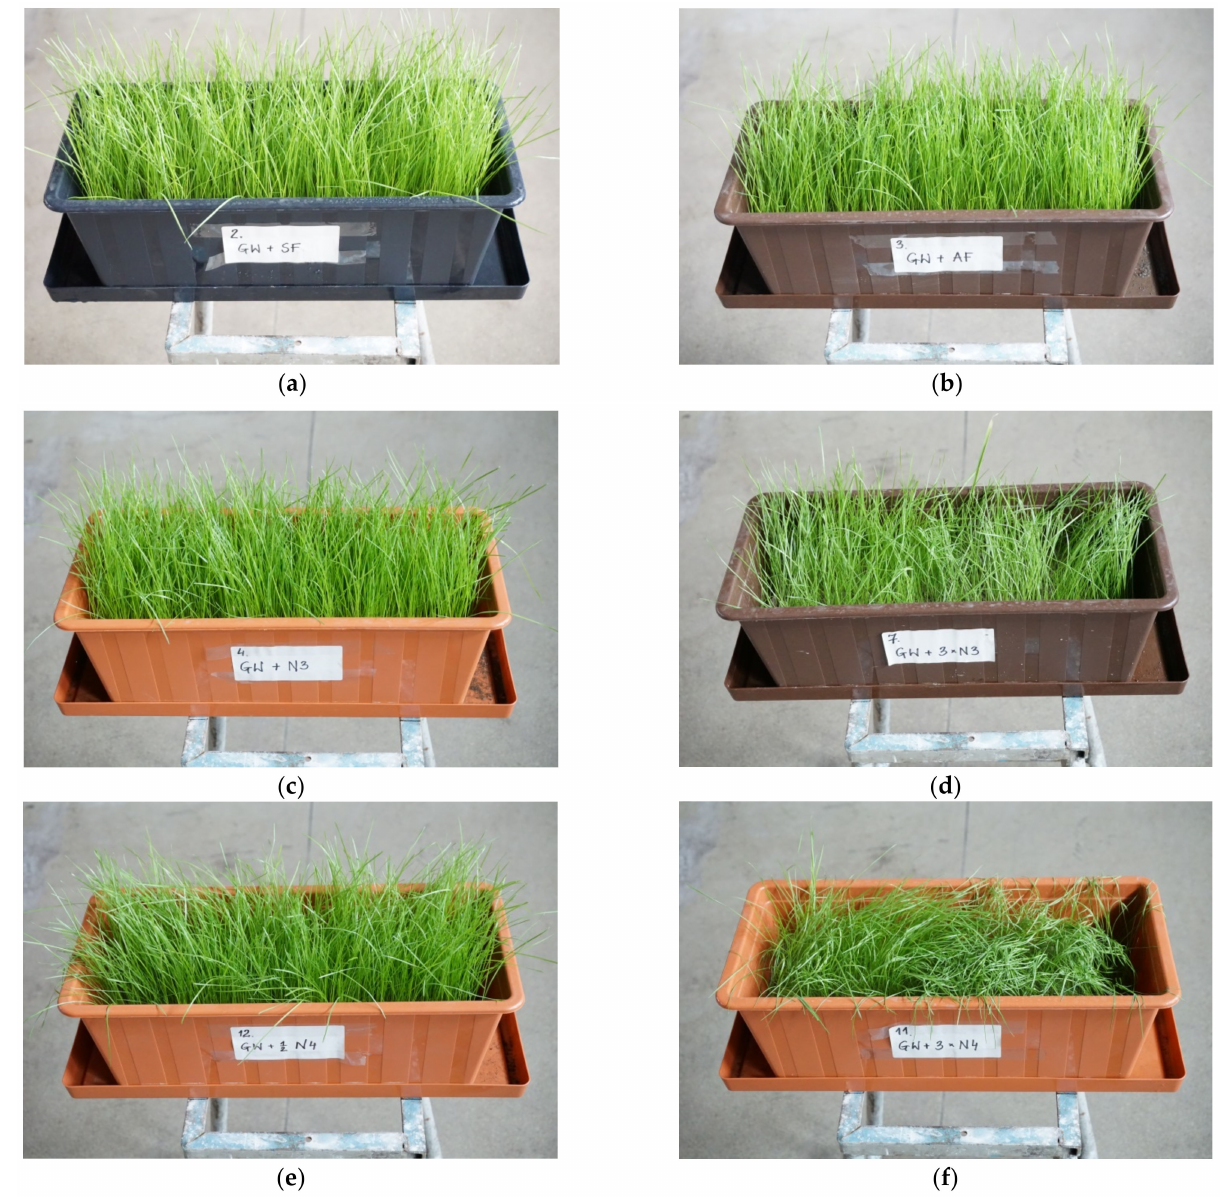
Figure 7. Pot cultivation–view on the 17th day from the start of cultivation: ( a ) biomass growth in test P2; ( b ) biomass growth in test P3; ( c ) biomass growth in test P5; ( d ) biomass growth in test P8; ( e ) biomass growth in test P9; ( f ) biomass growth in test P13–visible different height and condition of sown grasses. Explanations: test symbol according to Table